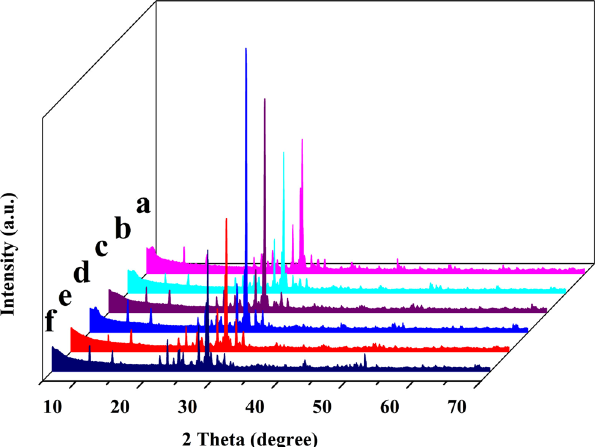
Figure 3. XRD patterns of ( a ) RMF ( b ) MMF-H2.5 ( c ) MMF-OH3.0 ( d ) MMF-La5.0 ( e ) CMMF-400 and ( f ) CMMF-H2.5-400.